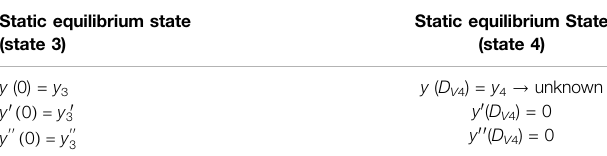
TABLE 5 | Postshake subphase conditions (vertical movement). Static equilibrium state (state